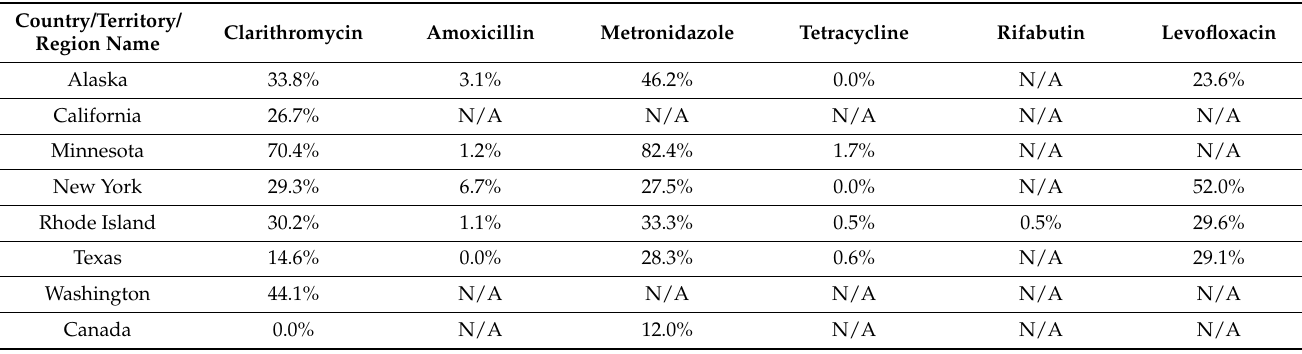
Table 2. North America Regional Rates of